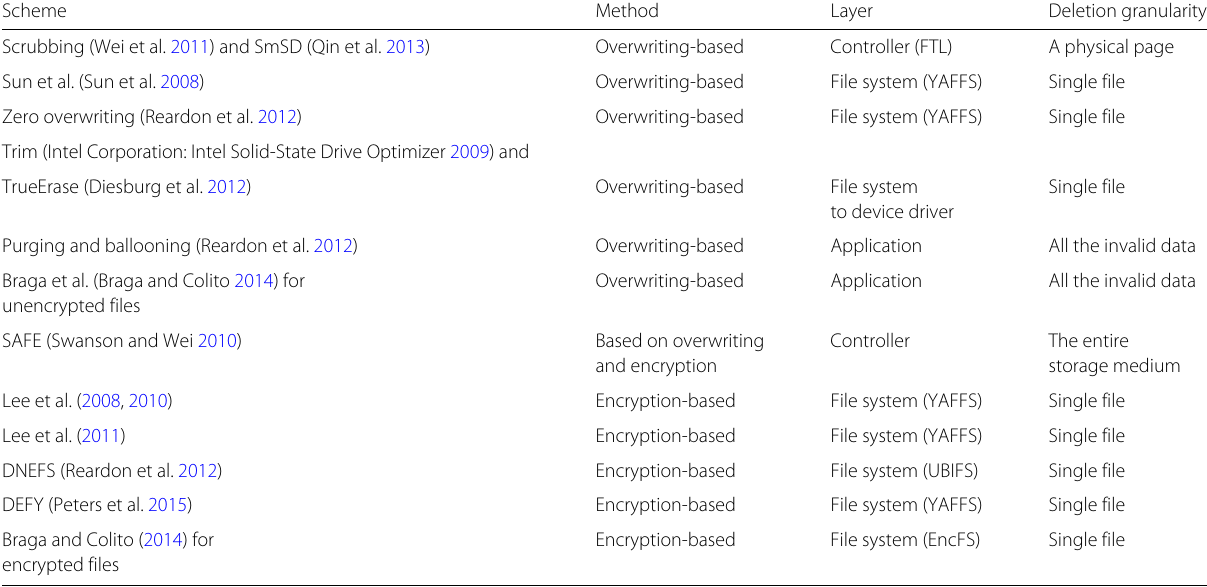
Table 4 Comparison of features offered by secure deletion approaches for flash-based storage systems Scheme Scrubbing (Wei et al. 2011) and SmSD (Qin et al. 2013)